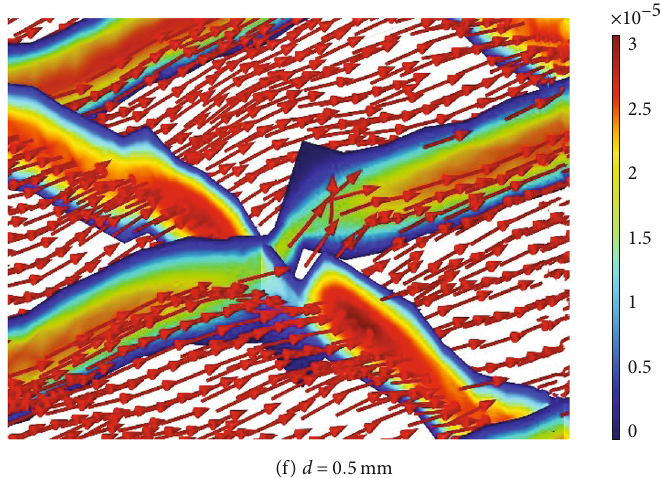
Figure 4: Percolation result diagrams of rough fracture